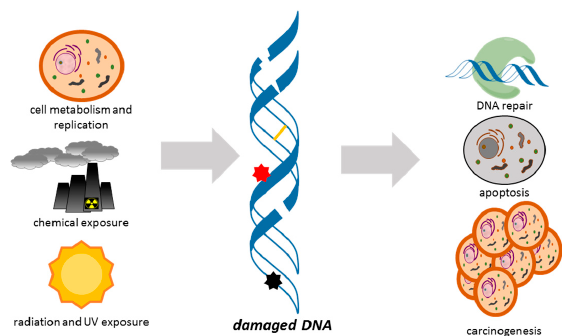
Figure 1. Our DNA is damaged by normal cell processes, contaminants in our food and environment, radiation and ultraviolet light. Damage may include strand-breaks, crosslinks (yellow line in DNA), or adducts (black and red stars). If not repaired, DNA damage can lead to cell death or heritable mutations and